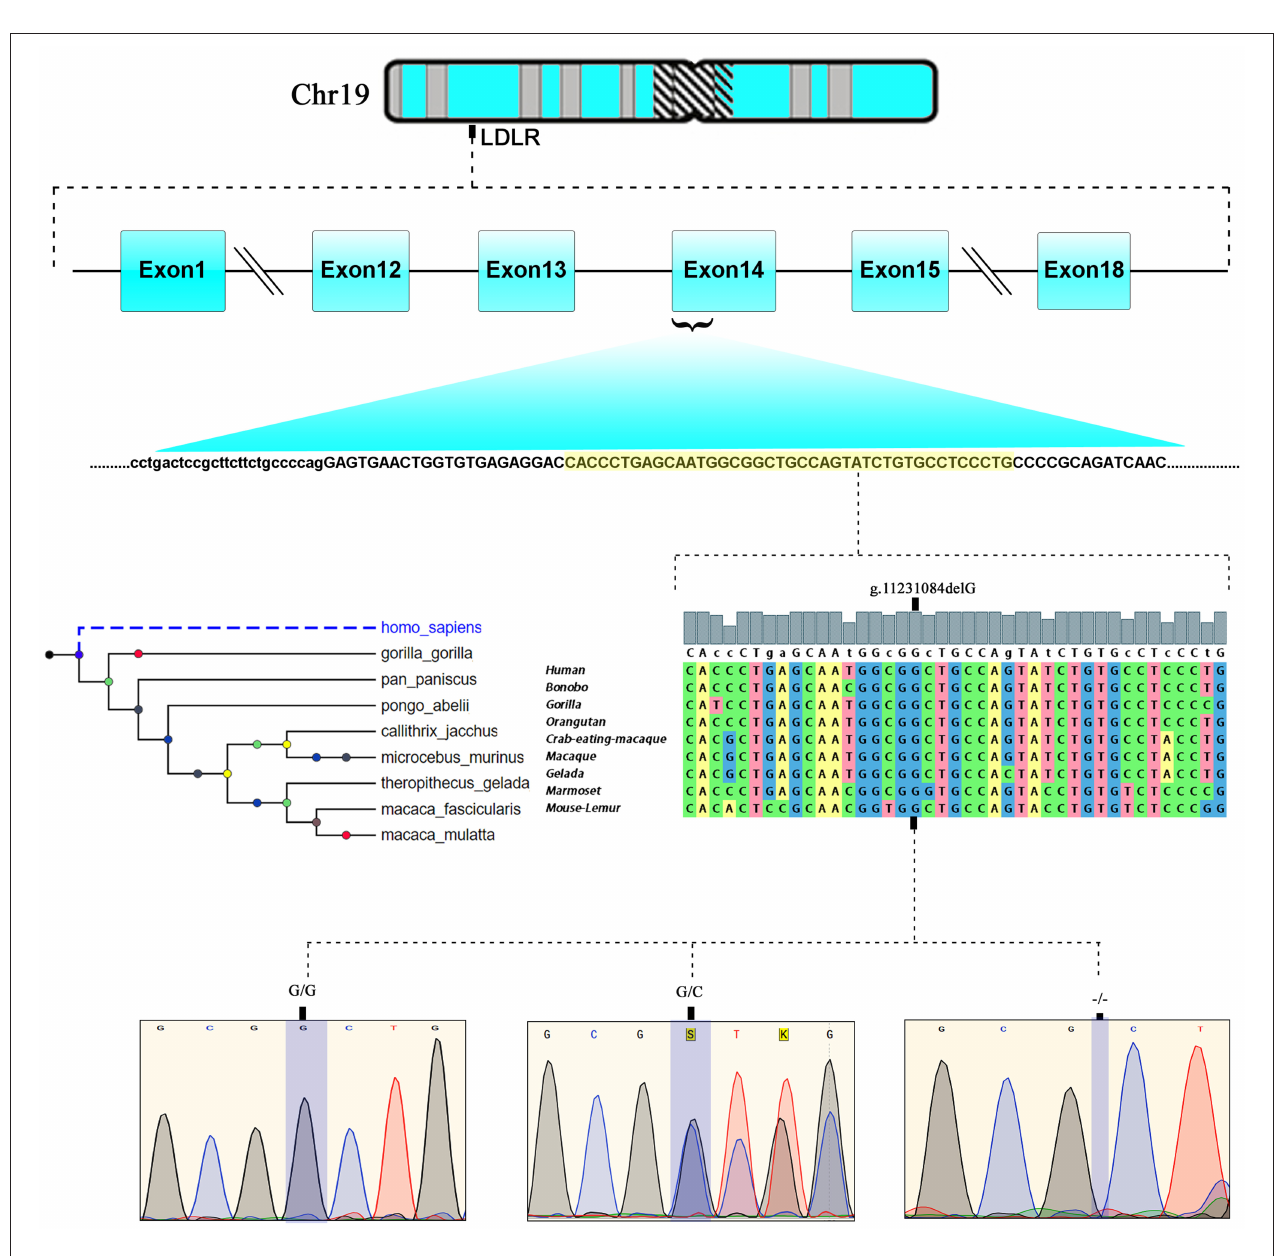
FIGURE 3 | Chromosomal location of human LDLR gene at chromosome19p13.2. exonic position and multiple sequence alignment showing the LDLR , EGF like domain sequence across different mammalian species and chromatograms of c.2027delG variant showing wild type (GG), heterozygote (G/ − ), and homozygous mutant ( − / − )